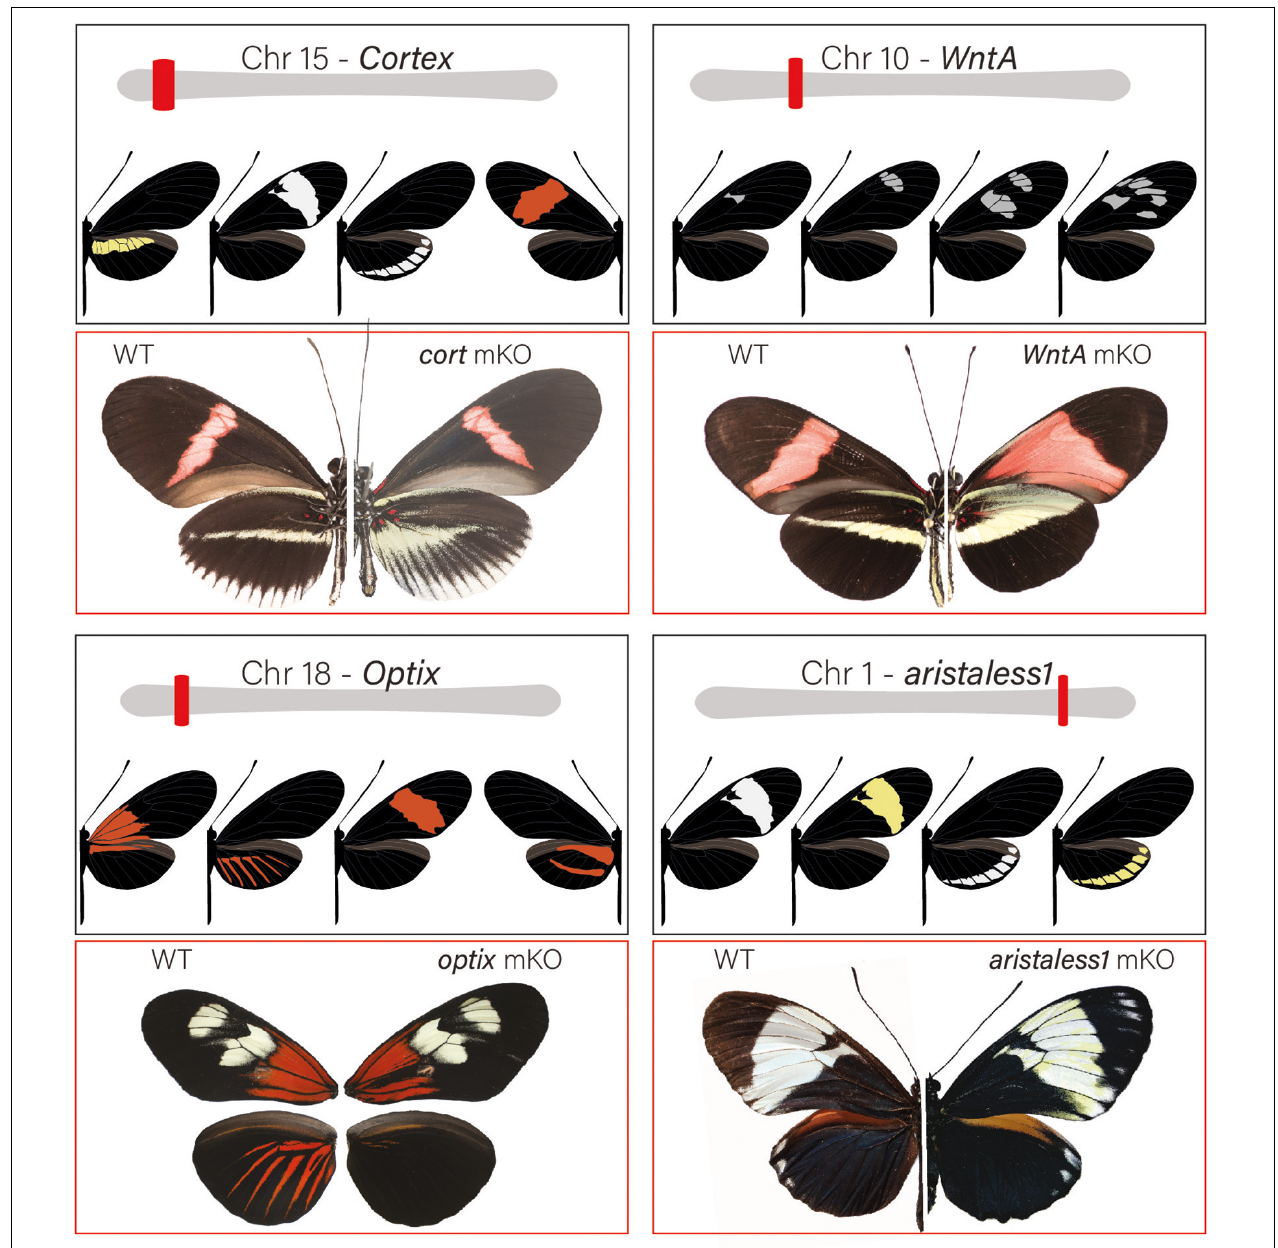
FIGURE 3 | Major patterning switch genes in Heliconius butterflies: Most of the color pattern variation in Heliconius is the result of 4 major effect loci. Loci are unlinked and allelic variation around them is associated with both convergent and divergent change among species. Over the past decade, loci have been positionally cloned and genotype × phenotype, expression and, most recently, KOs with CRISPR/Cas9 have identified specific patterning genes. The gene cortex is located on chromosome 15 and variation around the gene is associated with differences in the yellow hindwing bar, forewing band color, and the white margin and ventral color phenotypes among different geographic morphs of H. erato and H. melpomene . In H. numata , variation around the region that contains cortex controls all variation in wing patterns and is responsible for differences in yellow, orange, and black pattern elements among sympatric color pattern morphs (Nadeau et al., 2016; Saenko et al., 2019). cortex KO results in the appearance of Type I scales across the wing surface of Heliconius butterflies (see Livraghi et al., 2020). The signaling ligand WntA is on chromosome 10 and variation around the locus is associated with differences in forewing band size, shape and position in H. erato and other Heliconius species. KO results in the expansions of color pattern elements in proximal wing regions in H. erato , but generates a wide variety of phenotypic effects across the Heliconius radiation (Concha et al., 2019). The gene optix is on chromosome 18 and variation around this gene is responsible for variation in red color pattern elements. optix KOs result in the transformation of red Type III scales to melanic Type II scales. Finally, variation around the gene aristaless1 on chromosome 1 modulates the presence or absence of yellow pigment in Type I scales. Aristaless1 KOs result in the development of yellow scales suggesting that the gene represses synthesis/deposition of the yellow pigment, 3-hydroxy- L -kynurenine.